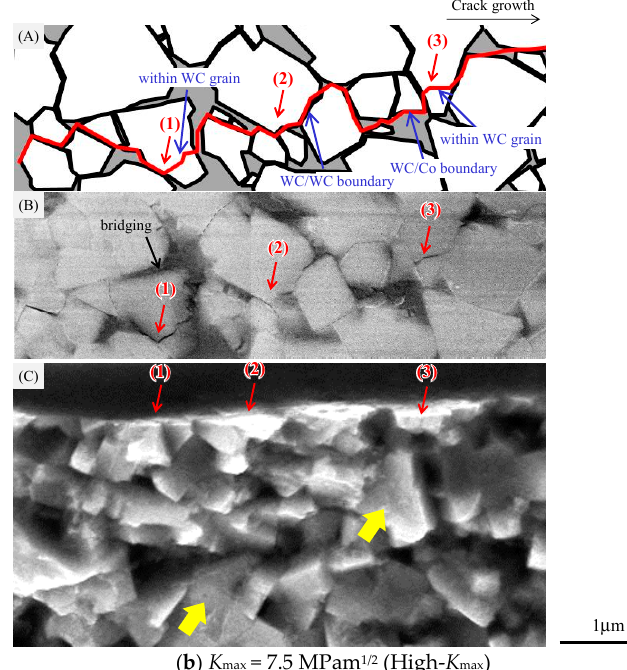
Figure 9. Observations of crack growth paths at R = − 1. Tests were conducted at a constant value of K max ; ( a ) K max = 6.0 MPam 1/2 ; ( b ) K max = 7.5 MPam 1/2 ; ( A ) Schematic illustrations of the crack growth path; ( B ) SEM images of the specimen surface; ( C ) SEM images of the fracture surface.